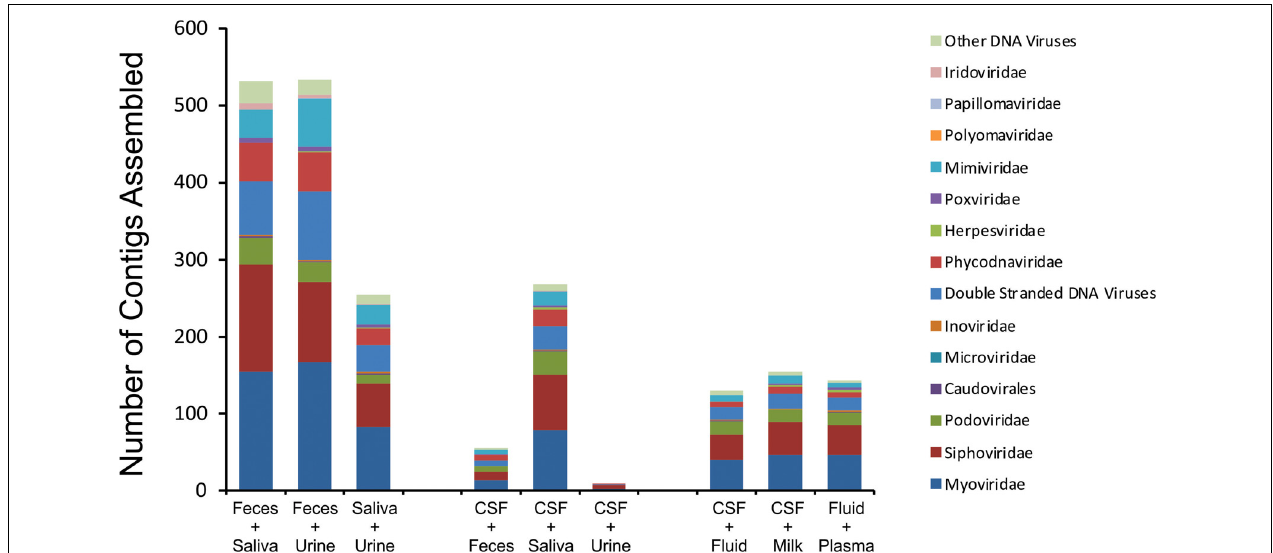
FIGURE 5 | Putative virus family assignments of contigs assembled from various human specimen types. The y-axis represents the raw number of contigs assembled assigned to each virus family, and the x-axis represents contigs assembled from specific